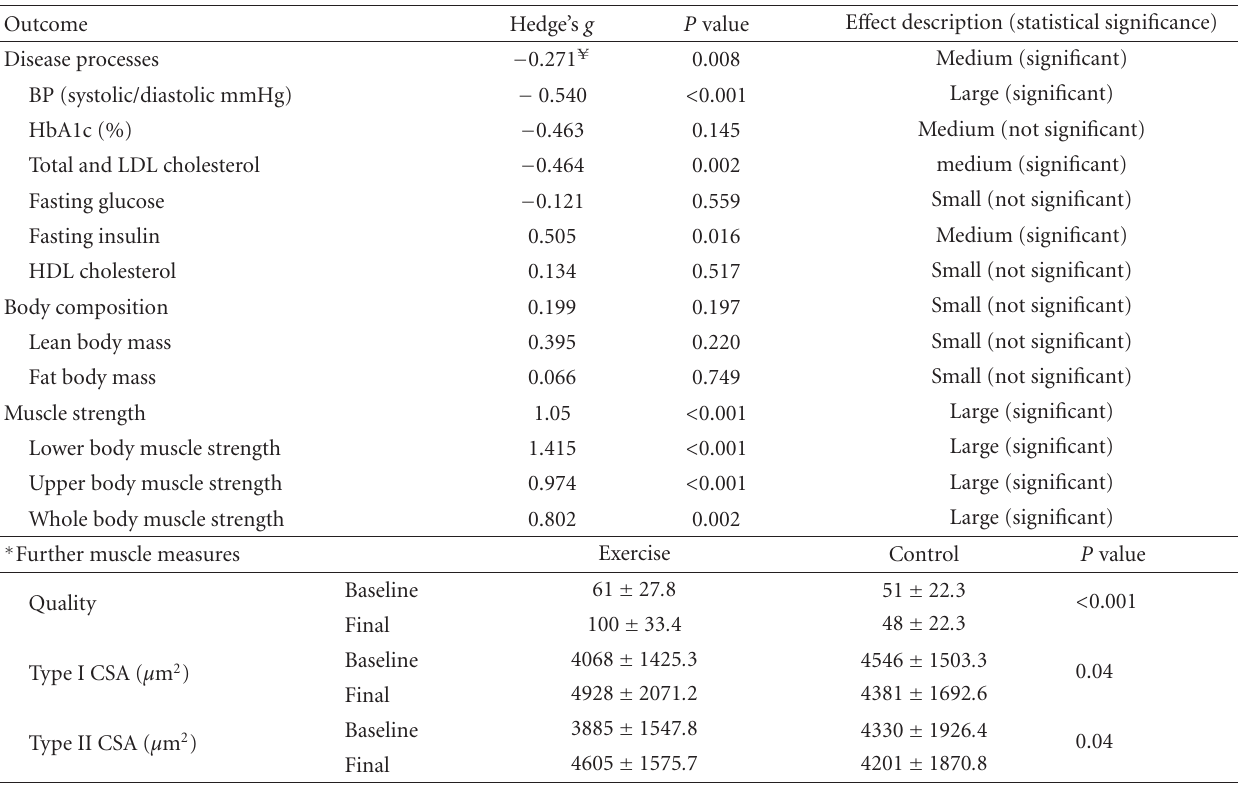
Table 6: Summary of resistance training e ff ect on outcome